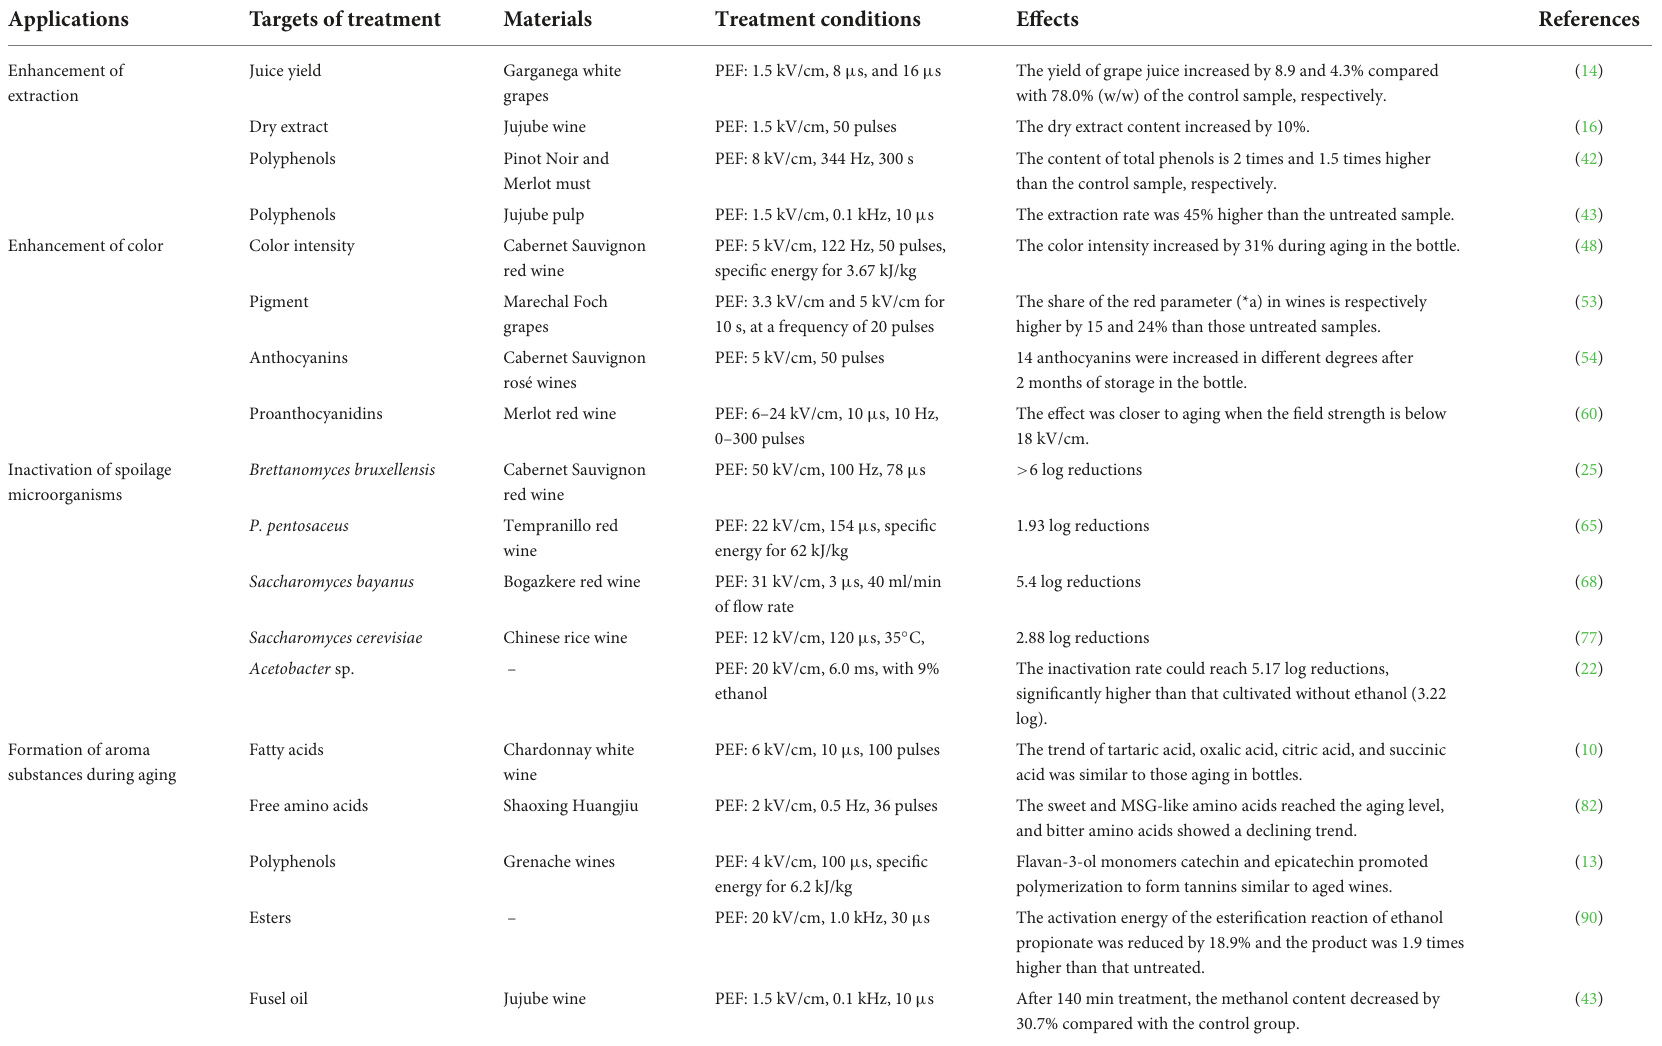
TABLE 1 Application examples of PEF treatment for fermented